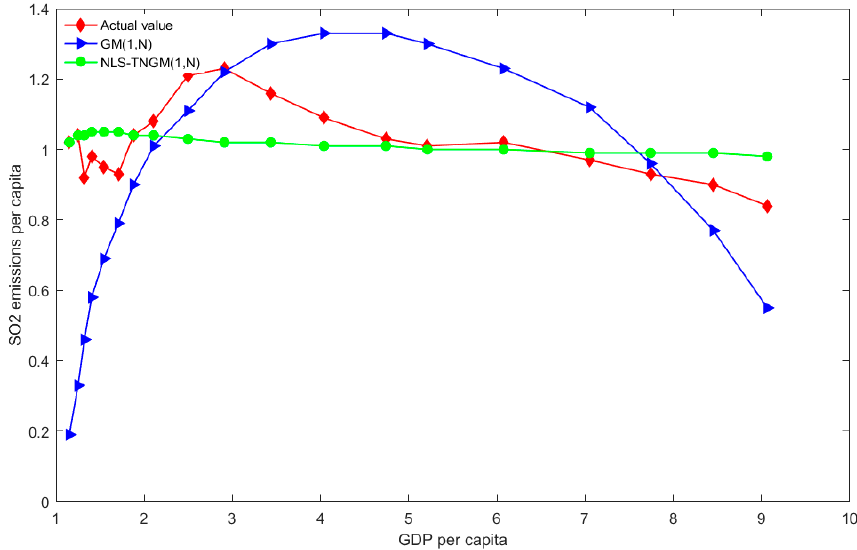
Figure 3. The distributions of forecasted values of SO 2 emissions per capita using the two models, and actual